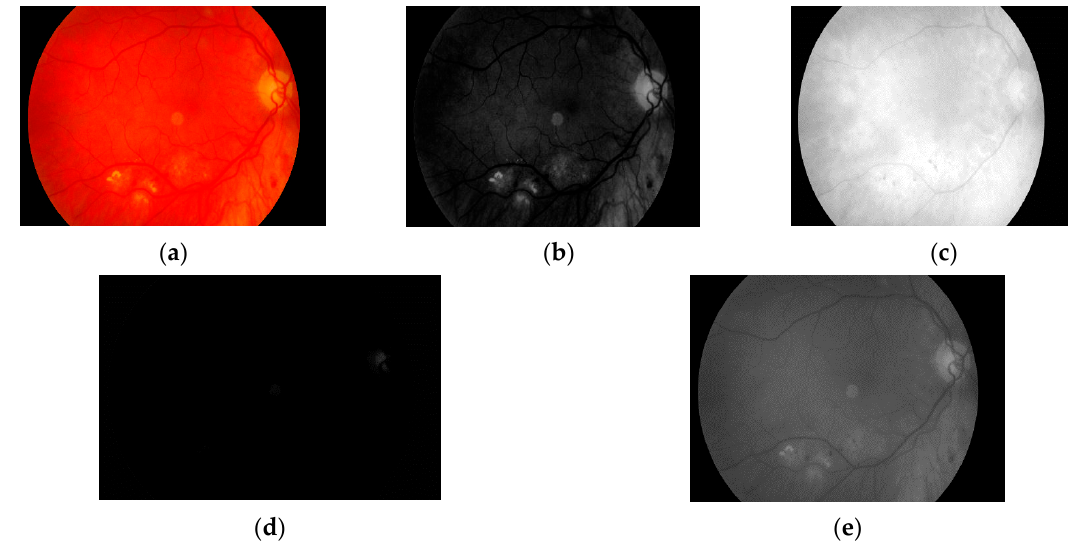
Figure 5. Visual comparison between different grayscale conversion methods: ( a ) original image; ( b ) green channel; ( c ) red channel; ( d ) blue channel; ( e ) average value of all channels.